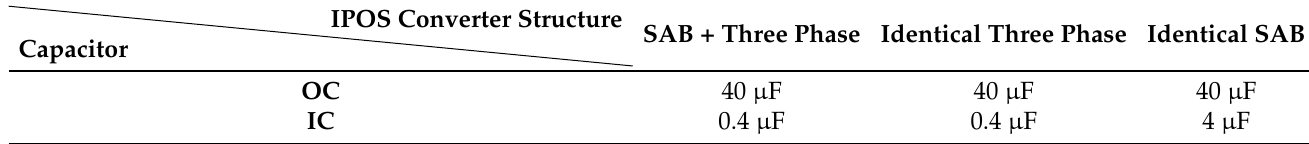
Table 3. Filter selected for systems with different kinds of IPOS converter